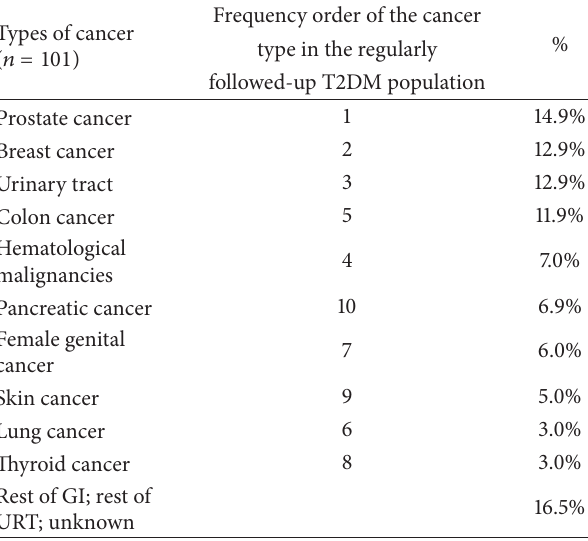
Table 4: Types of cancer in T2DM patients lost to follow-up. Types of